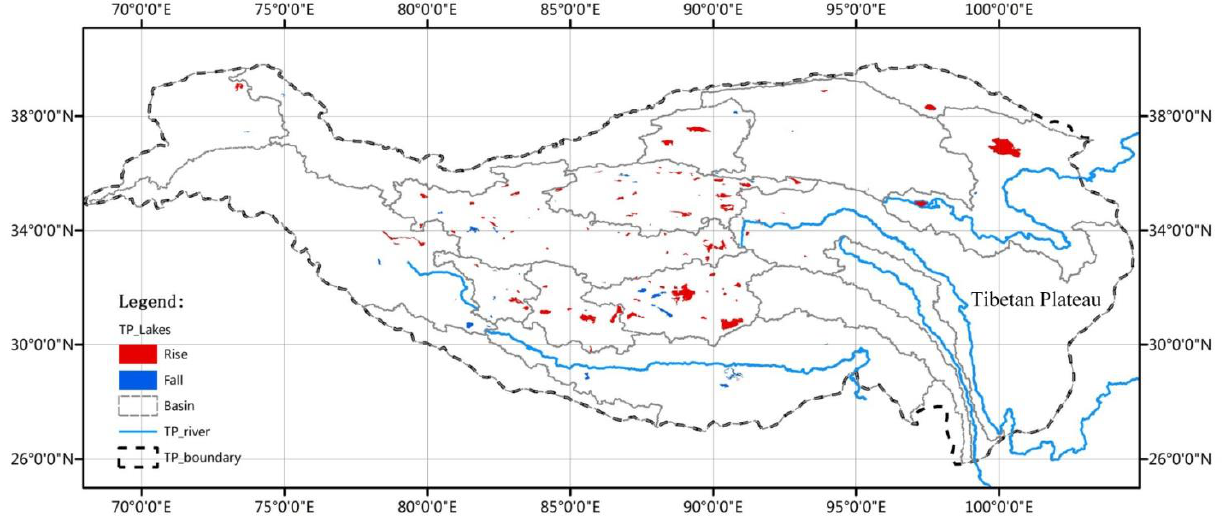
Figure 4. Lake water level changes in the Tibetan Plateau from 2002 to 2012